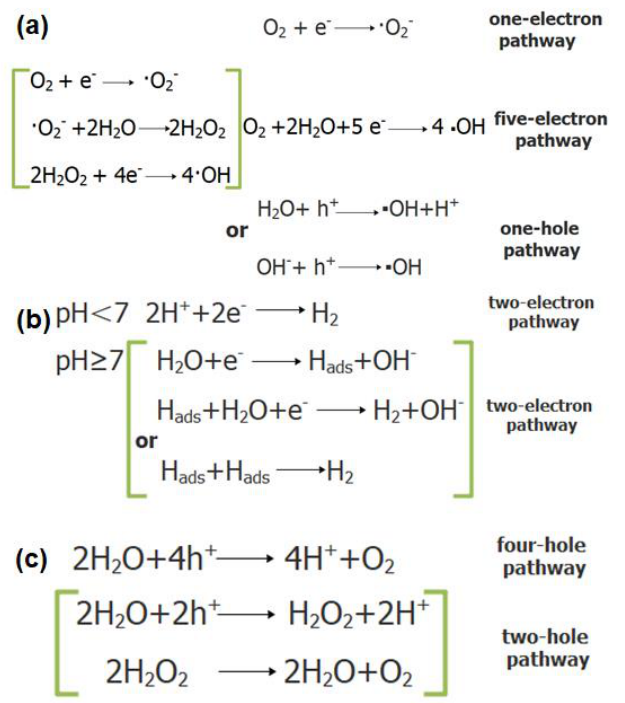
Figure 1. Hydroxyl radical obtained via two pathways ( a ), hydrogen production via photocatalysis of water ( b ), and oxygen production via photocatalysis of water ( c ).